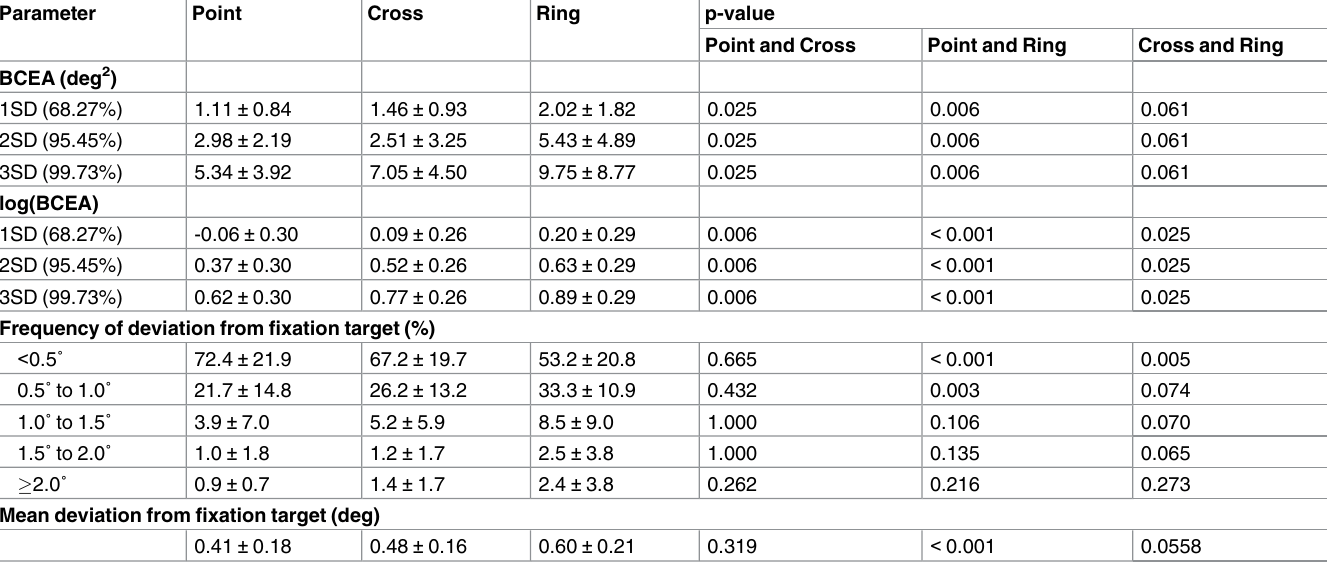
Table 2. Comparison of Fixation Behavior and its Frequency among the Point, Cross, and Ring